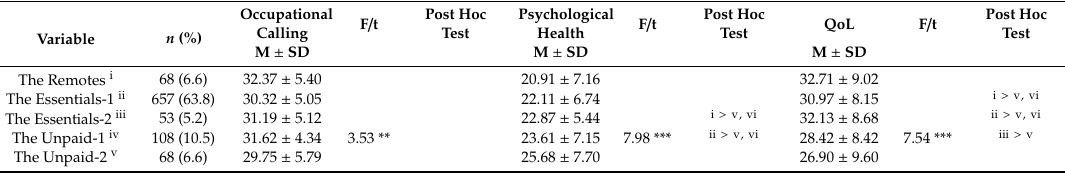
Table 4. Participants’ calling, psychological health, and QoL according to our Korean-adapted version of the new classes of occupation owing to the COVID-19 pandemic ( N =